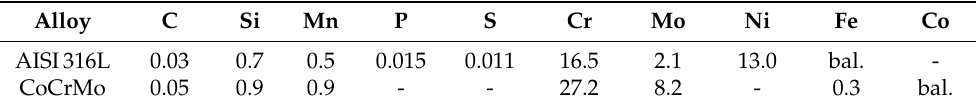
Table 1. Chemical composition of the powder materials used in the investigation. In wt.%. AISI316L also used in